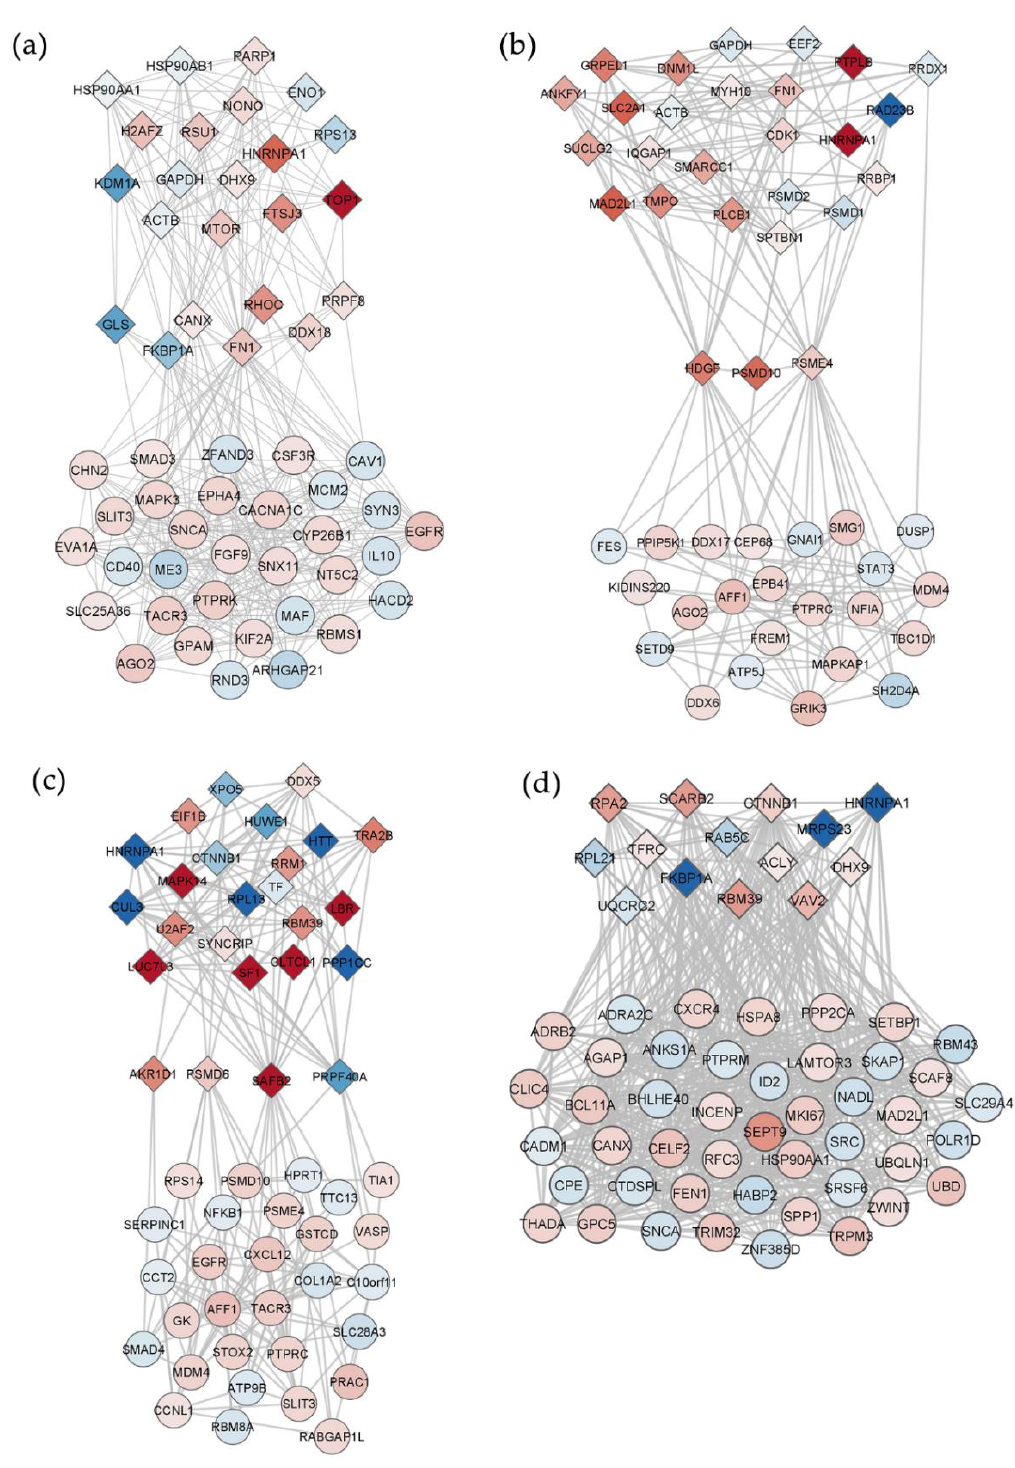
Figure 5. Interaction networks between DEGs (circles) and DEPs (diamonds) in HepG2 cells treated for 72 h with ( a ) BDE-47, ( b ) BDE-99, ( c ) BDE-209 or ( d ) MIX at 1 nM. Only nodes with BC, CC, and D > 90th percentile are shown, except for MIX where the threshold was the 95th percentile. Shades of blue and red represent, respectively, the magnitude of down- or upregulation.